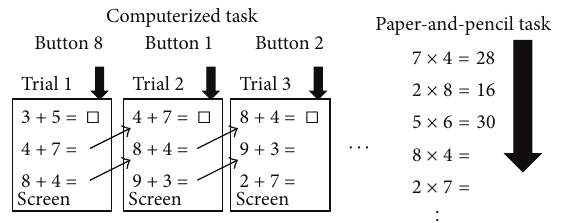
Figure 1: Schema of examples of training tasks used in this study. Trainingtasksconsistedofcomputerized(addition,subtraction,and multiplication) and paper-and-pencil (addition, subtraction, and multiplication)